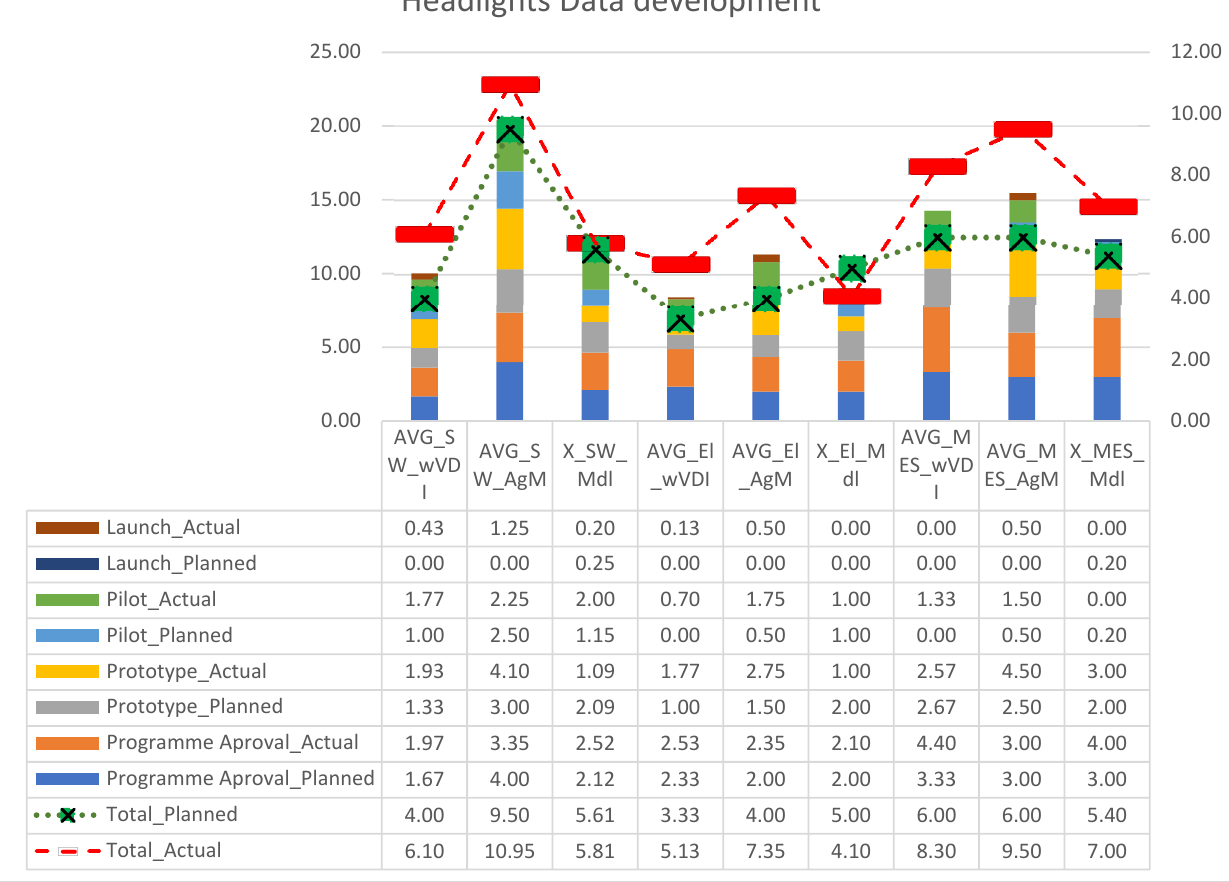
Figure 7. Delivery baseline LED-based Headlight development—planned versus actual.